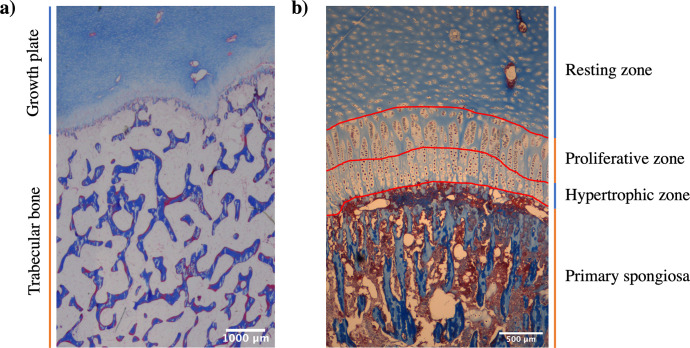
Mason trichrome stained sections of cattle’s growth plate and trabecular of tuber coxae bone and photographed at 1X (a) and 4X (b) objectives. Histomorphometric assessments were conducted at the trabecular bone (a) as well as at the proliferative and hypertrophic zones of the growth plate (b).